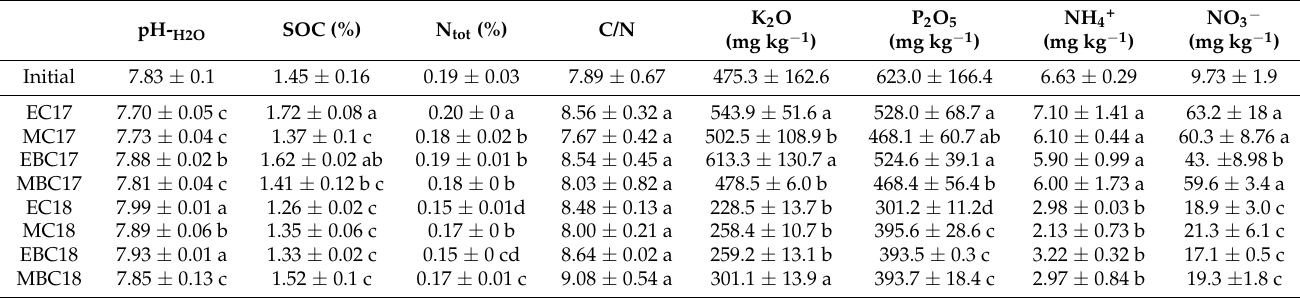
Table 2. Chemical characteristics of the soil without (E) and with maize (M) or biochar (BC) amendment during 2017 (17) and 2018 (18) of the experiment. Initial data represents the average values of the soil samples collected prior to plant sowing or biochar application. n = 3; mean ± SD. Small letters represent statistically significant differences between groups (ANOVA with Tukey’s